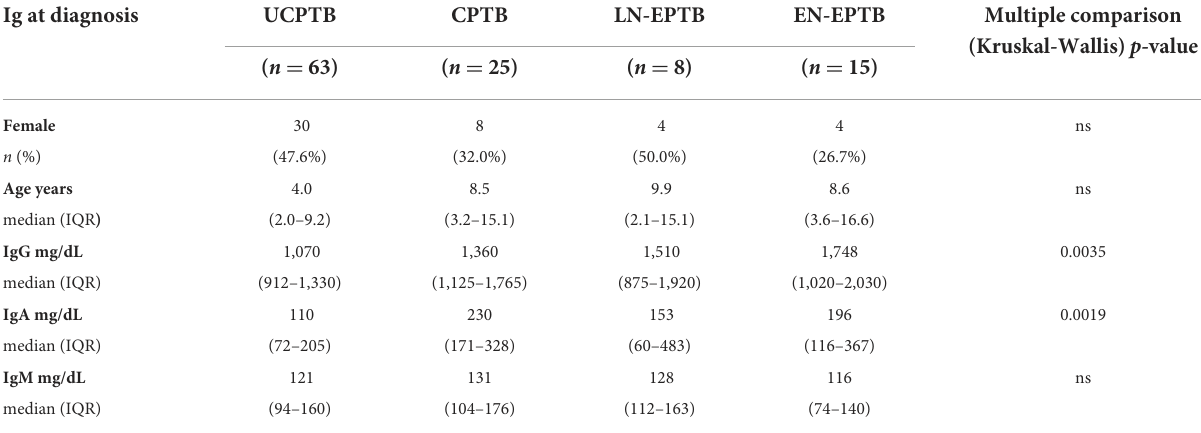
TABLE 1 Demographic data and serum Ig levels at diagnosis in the four TB study groups. Ig at